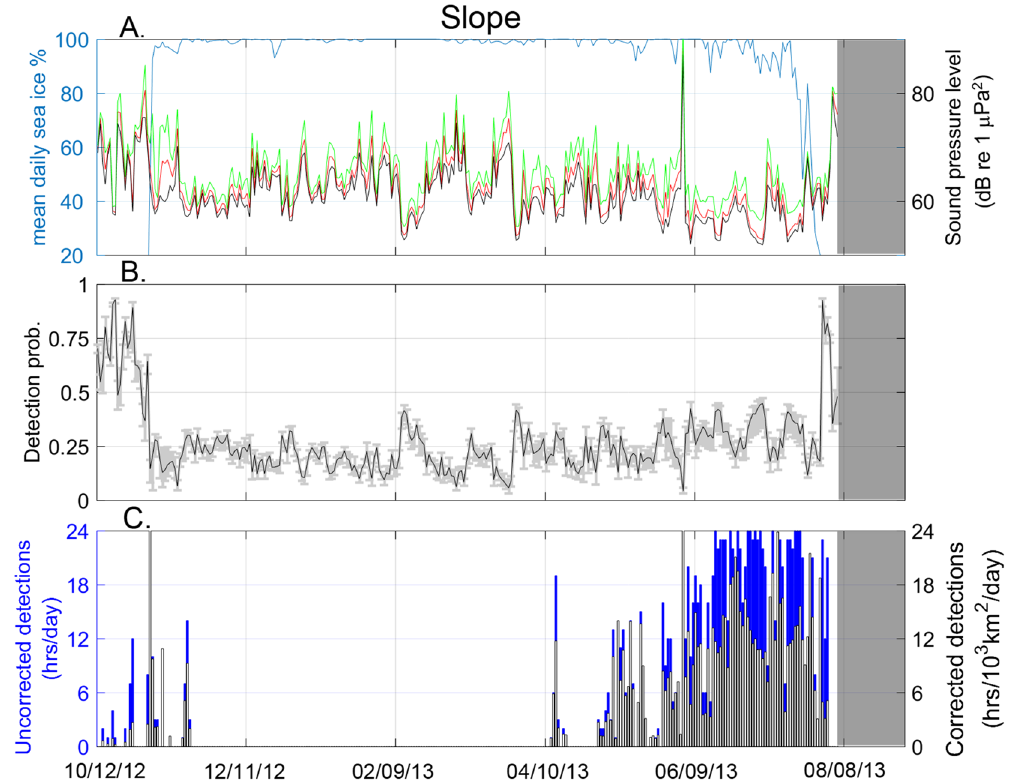
Figure 8. Slope site ( A ) Average daily ambient noise levels in daily 10th 50th, and 90th percentiles (black, red, and green lines, respectively) for 80–180 Hz frequency band and mean daily sea ice concentration (blue line from October 2012 to October 2013. ( B ) Daily detection probability within a 40 km radius, gray bars show range for the 90th and 10th percentile noise level. ( C ) Bowhead whale call detections as uncompensated daily detection hours (blue bars) and compensated detection density (black and white bars). Gray shaded areas indicate period of no